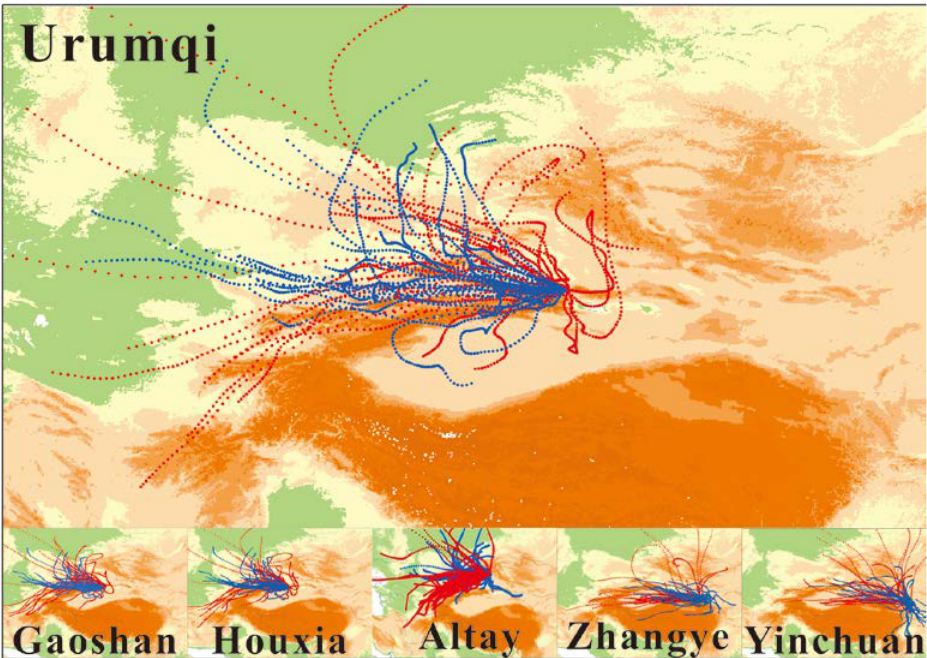
Figure 2. Moisture trajectories at selected stations of Urumqi, Gaoshan, Houxia, Altay, Zhangye, and Yinchuan in Northwest China: red lines represent January (winter); blue lines represent July (summer).